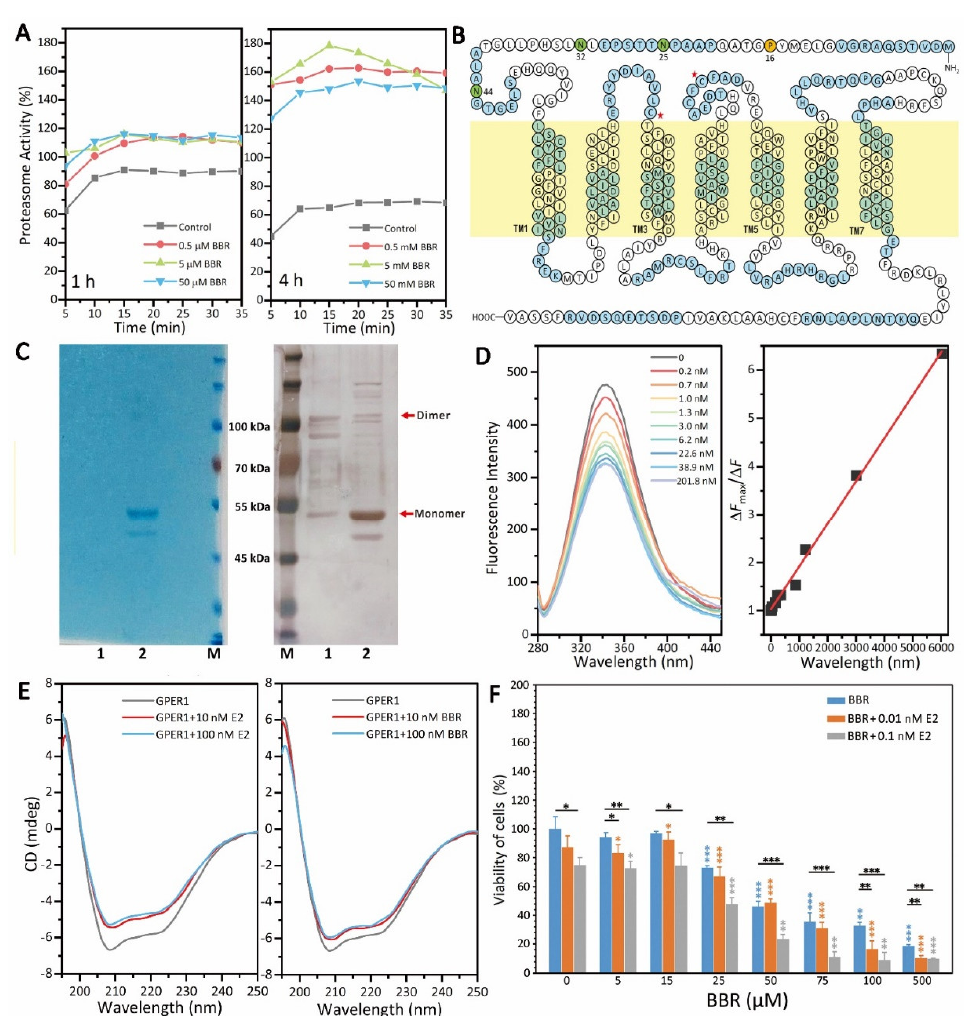
in the 1- and 4-h treatment groups. Compared with the 1-h results, the protein levels of SQSTM1 were significantly increased with the 4-h treatment of BBR (0.5 µ M, p < 0.01; 5 and 50 µ M, p < 0.05). The protein levels of MAP1LC3-II were decreased after 1-h treatment with 50 µ M BBR ( p < 0.01) and 50 nM RAP ( p < 0.05). However, compared with the control groups, the protein levels of MAP1LC3-II did not show a distinct change with all the treatments after 4 h, indicating that MAP1LC3-II in all the groups had consumed a lot with time, which might weaken the differences between groups. As shown in Figure 4C,E, the increase in the MAP1LC3-II/MAP1LC3-I ratio in the 4-h treatment with 50 µ M BBR was statistically significant ( p < 0.05), which was similar to that with 5 µ M CQ ( p < 0.01). Considering that the transcription of SQSTM1 was inhibited, the protein levels of SQSTM1 were increased, together with the decrease in ALs and increase in the MAP1LC3-II/MAP1LC3-I ratio. Thus, we believe that BBR could inhibit autophagy in MDA-MB-231.